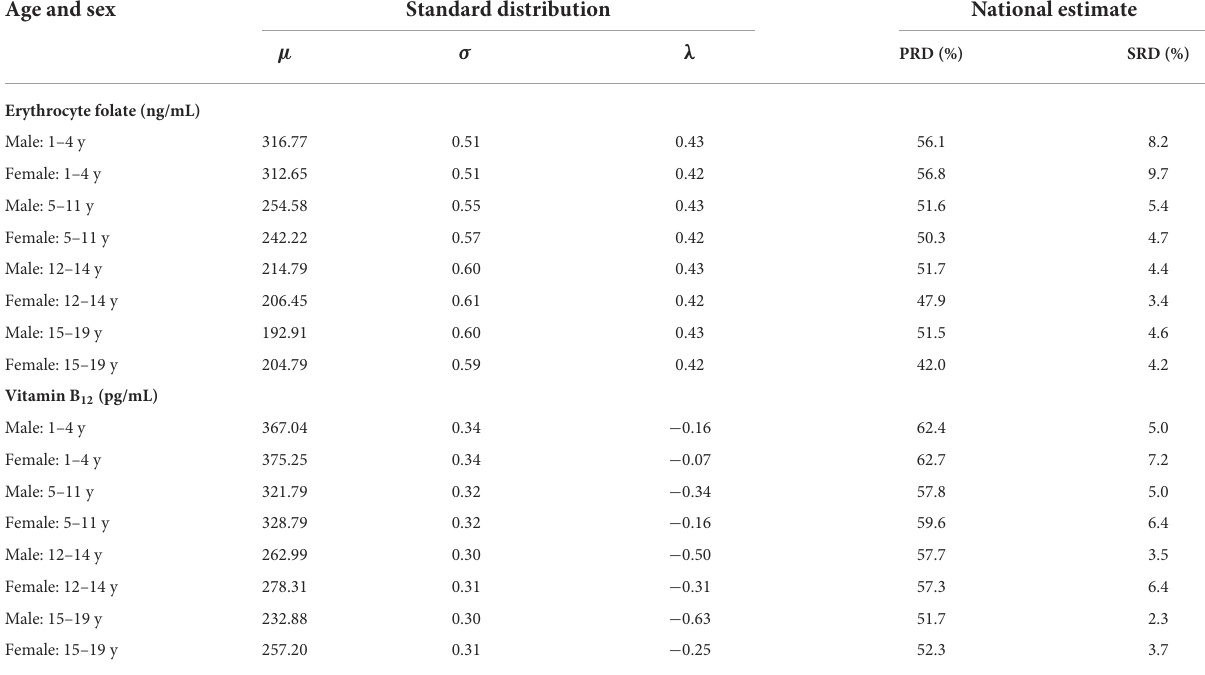
TABLE 2 Standard distribution for erythrocyte folate, and serum vitamin B 12 concentrations derived by the LMS method across age and sex with national estimate of population risk of deficiency (PRD) and prevalence of severe risk of deficiency (SRD). Age and sex Standard distribution National